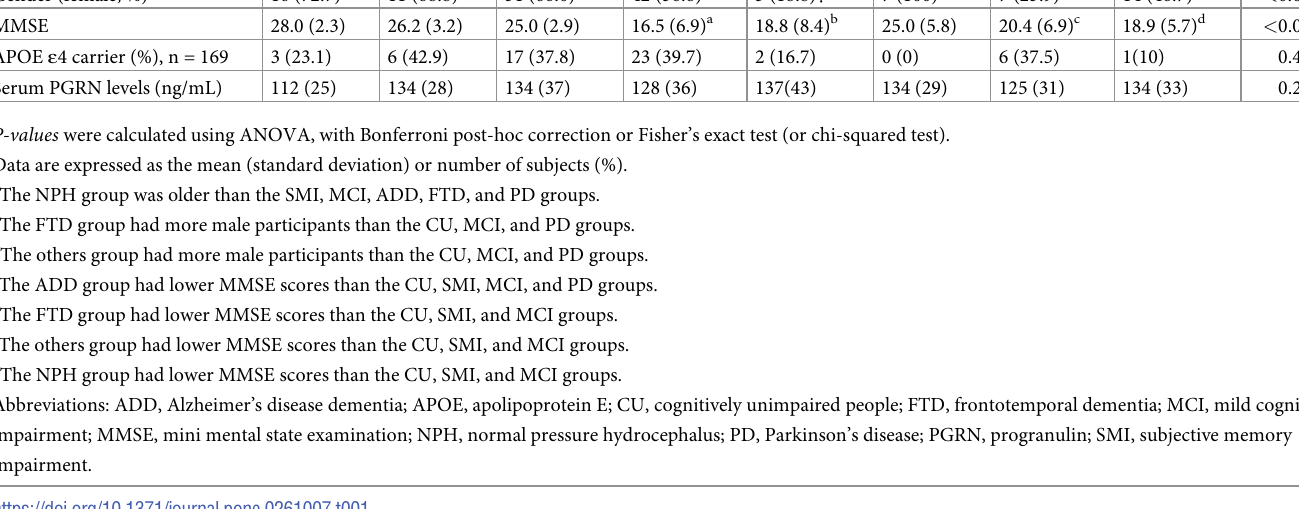
and one in-frame deletion of uncertain significance (VUS) in six patients (S1 Table and S1 Fig): exon 6 c.530G > A (p.Arg177His) in two patients with NPH (V2 and V3); exon 7 c.662G > C (p.Cys221Ser) in a patient with ADD (V4); exon 8 c.827C > T (p.Ala276Val) in a patient with unspecified dementia (V5), exon 13 c.1690C > T (p.Arg564Cys) in a CU participant (V6),